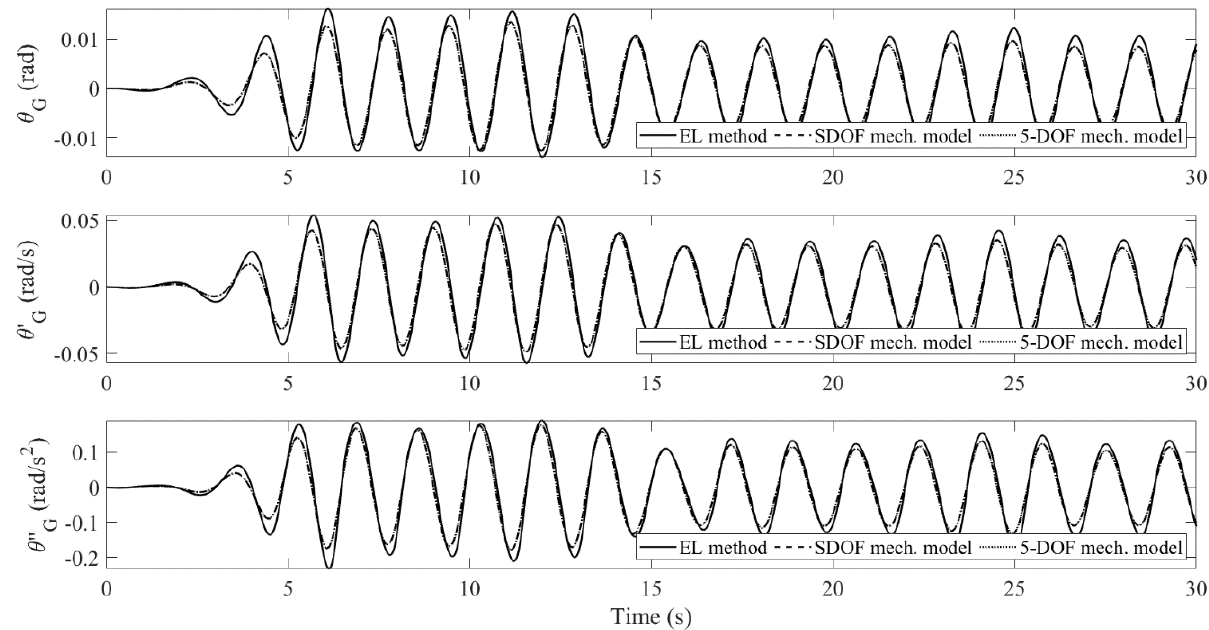
Figure 17. The vertical forces acting on the floating body for the small-wave case.